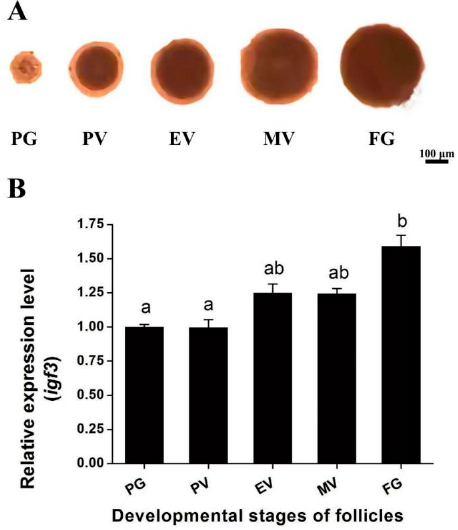
Figure 4. Stage-dependent expression of igf3 in developing E. coioides follicles. ( A ) Morphology of E. coioides follicular at different stages of maturation. PG—primary growth; PV—previtellogenic; EV—early vitellogenic; MV—midvitellogenic; FG—full-grown. ( B ) Expression of igf3 mRNA during different stages of ovarian follicle development. Different letters (a and b) indicate significant differences.